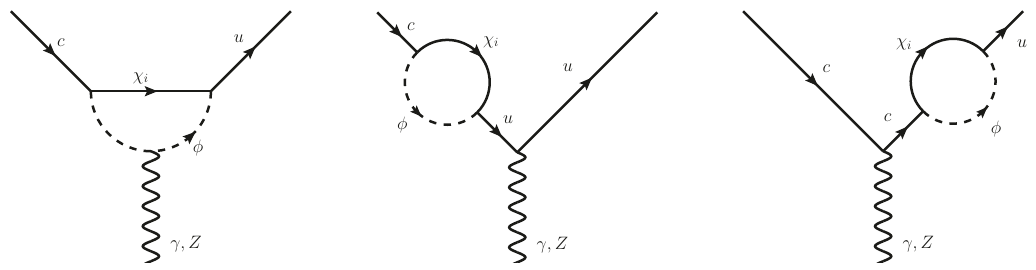
Figure 18 . The DMFV model contribution to the e(cid:11)ective operators governing rare decays of charm mesons, including explicit self-energy corrections to the external quark legs as explained in the text. The (cid:13); Z couple to a lepton